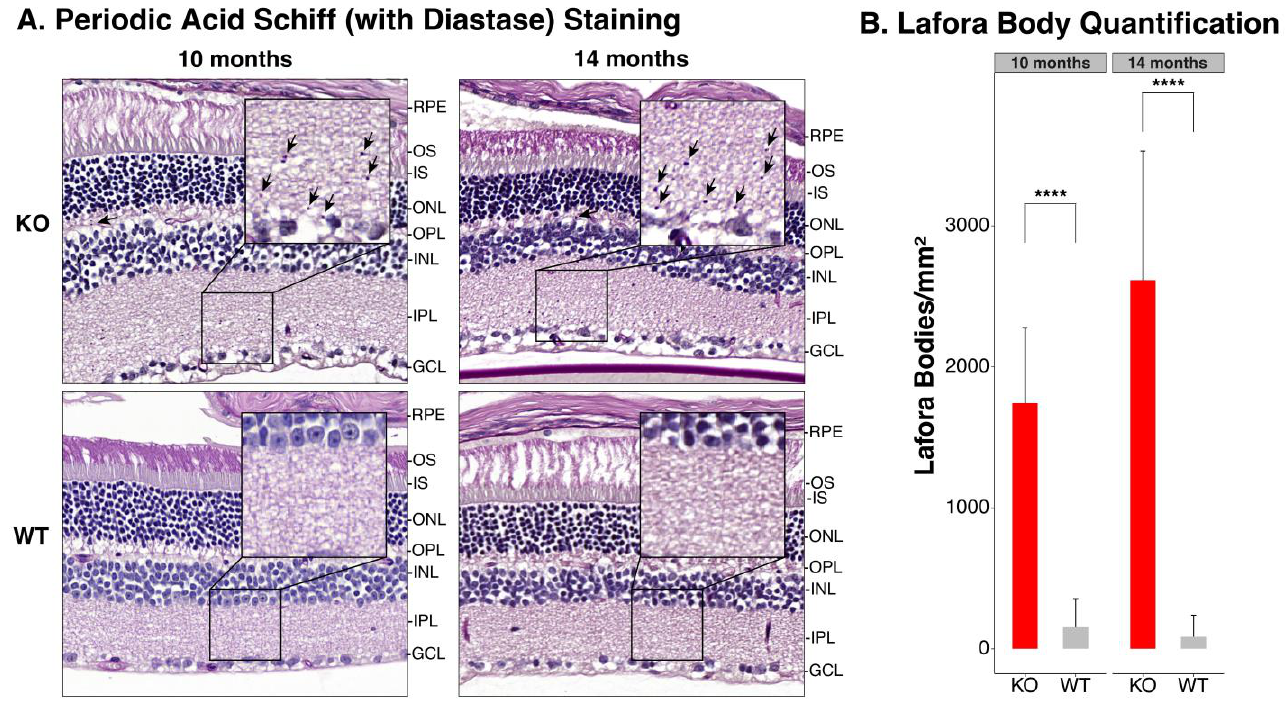
Figure 2. Periodic Acid Schiff-Diastase) (PASD) staining in Epm2a −/− knock out (KO) mice and control (WT) littermates. ( A ) PASD staining of KO mice shows Lafora body (LB) deposition in KO mice at both 10 and 14 months (top panel). The LBs (black arrows) were noted in the inner plexiform layer (IPL), inner nuclear layer (INL) and outer plexiform layer (OPL). The LBs were most numerous in the IPL. The LBs were not visualised in WT littermates (bottom panel). All the other retinal layers